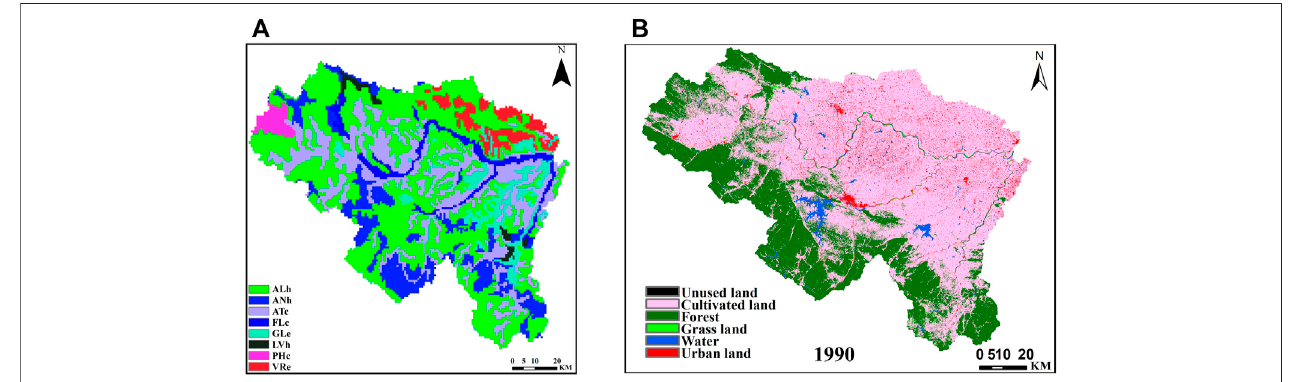
FIGURE 3 | Geographic information of the study area: (A) soil types and (B) land use.